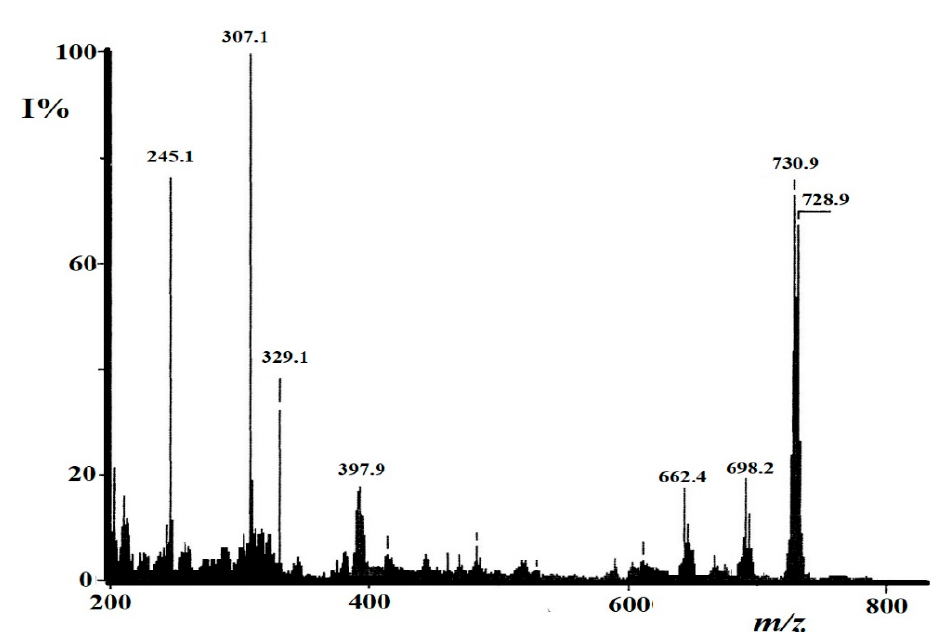
Figure 1. FAB-MS of the desired Cu(II)